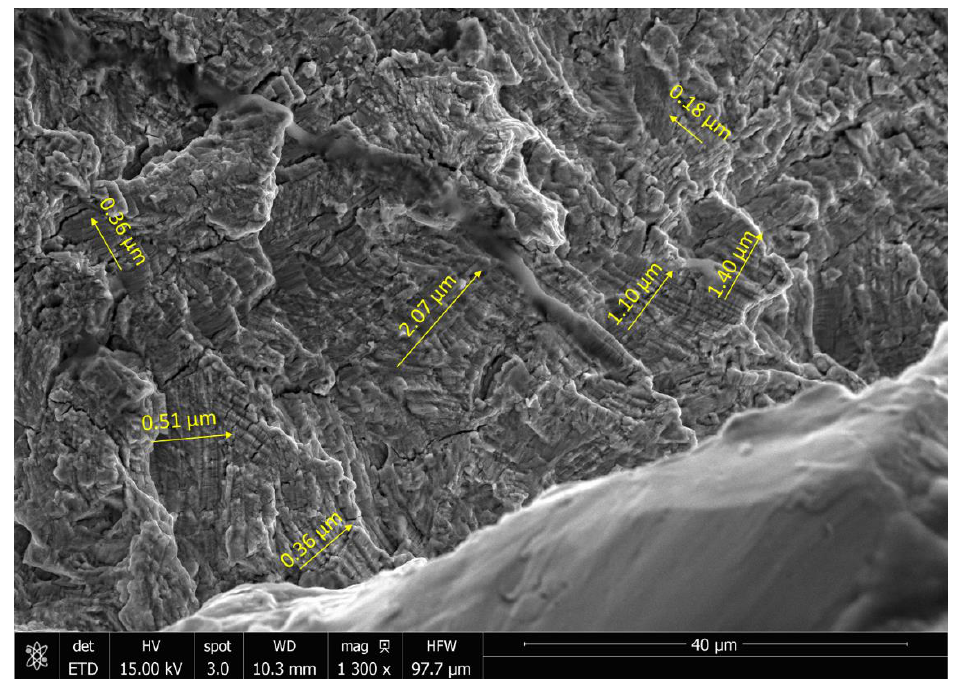
Figure A13. CS4 EDS showing Si-based inclusions. Bioengineering 2019 , 6 , x FOR PEER REVIEW